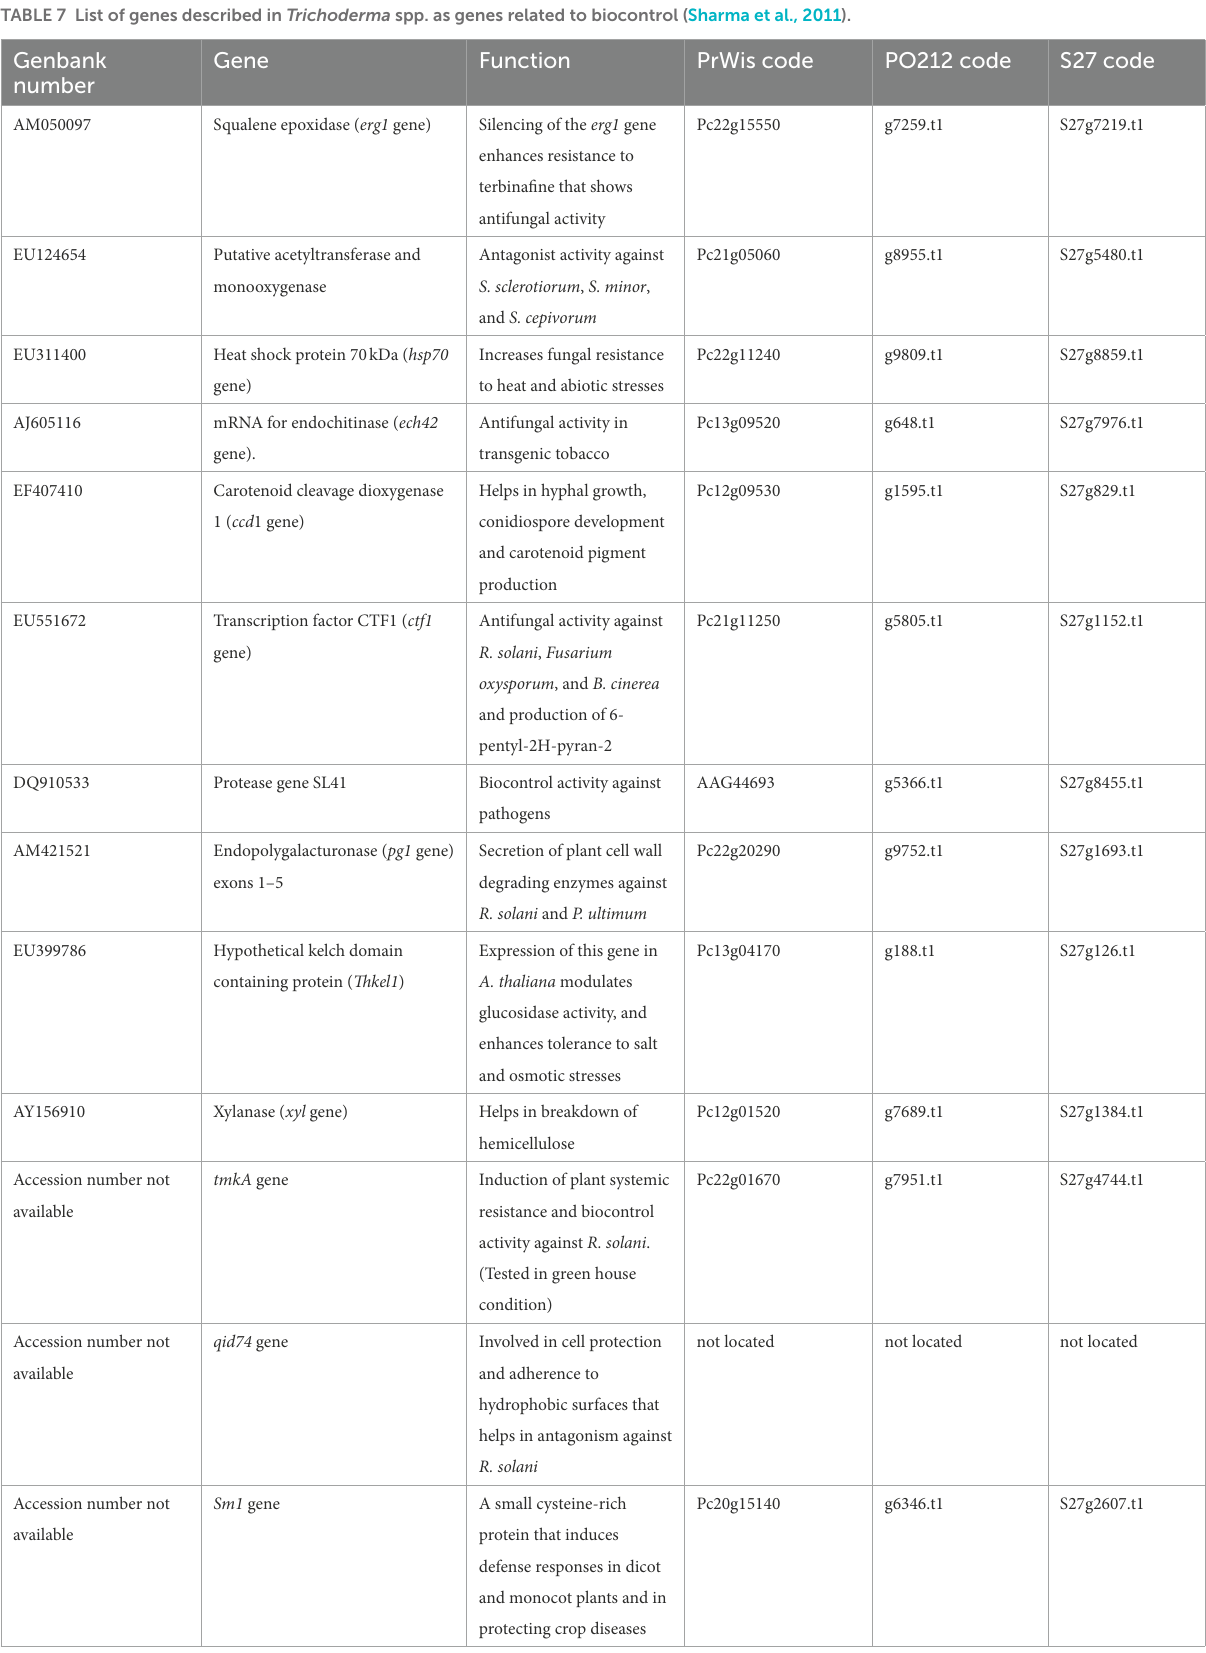
TABLE 7 List of genes described in Trichoderma spp. as genes related to biocontrol (Sharma et al.,